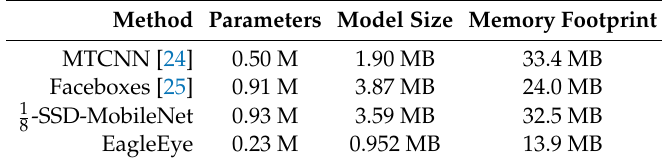
Table 7. Memory complexity comparisons between different methods with VGA